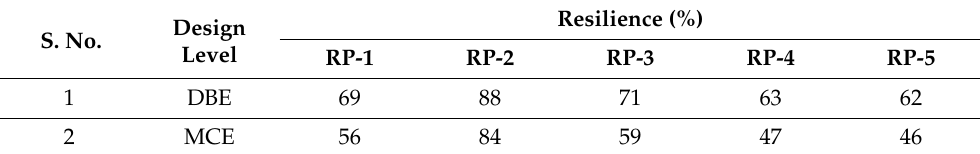
Table 19. Seismic resilience of unsymmetrical building under bidirectional loading (Case IV). S. No.